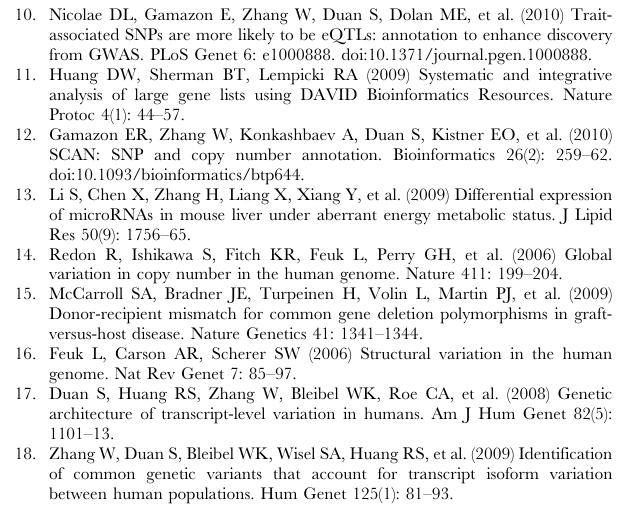
from the WTCCC survey is shown. Their minor allele frequency distribution differs markedly from the distribution of reproducible trait-associated SNPs from the NHGRI catalog. Figure S3 The size distribution of the CNVs from the WTCCC study is shown. CNV length ranges from 0.446 kb to 662 kb with average 14 kb. Table S1 We identified 33 CNVs harboring 50 or more SNP eQTLs that predict the expression of a transcript.